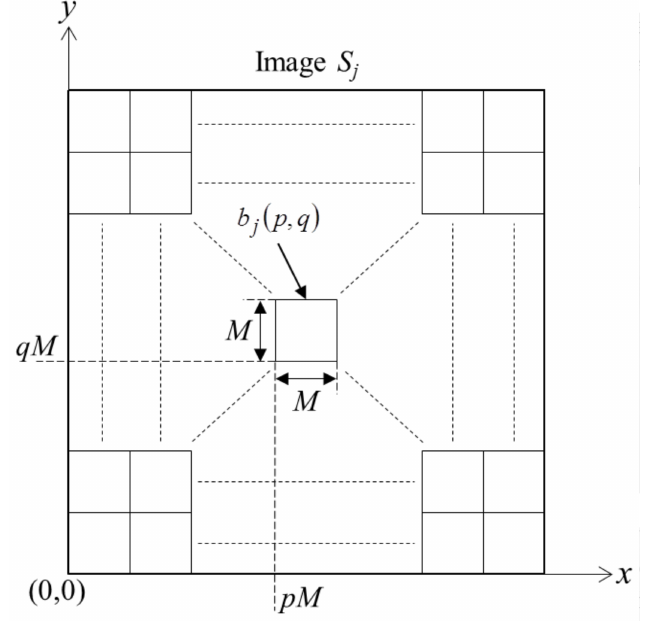
Figure 3. Partitioning an image S j ( x , y ) into non-overlapping square blocks of size M × M